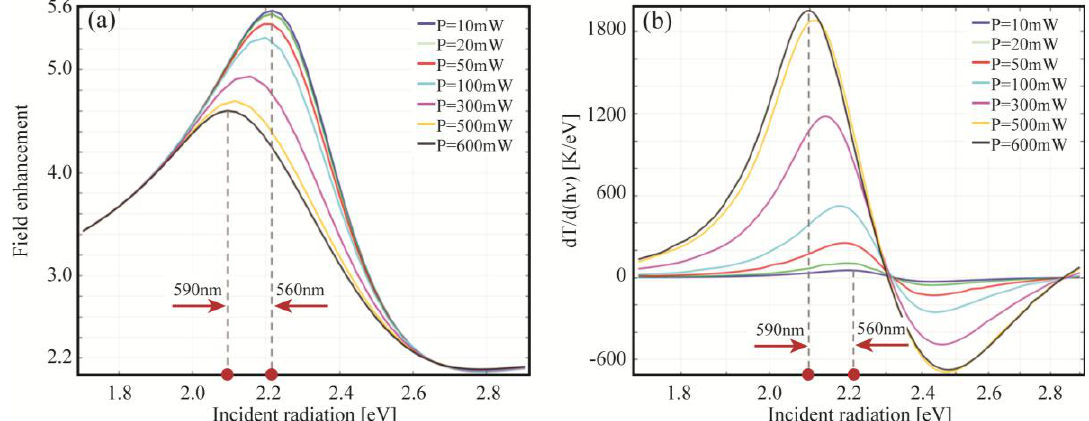
Figure 14. ( a ) Field enhancement; and ( b ) temperature derivative with respect to incident radiation energy for a gold nanospheres ( R = 10 nm) embedded in silica at different incident